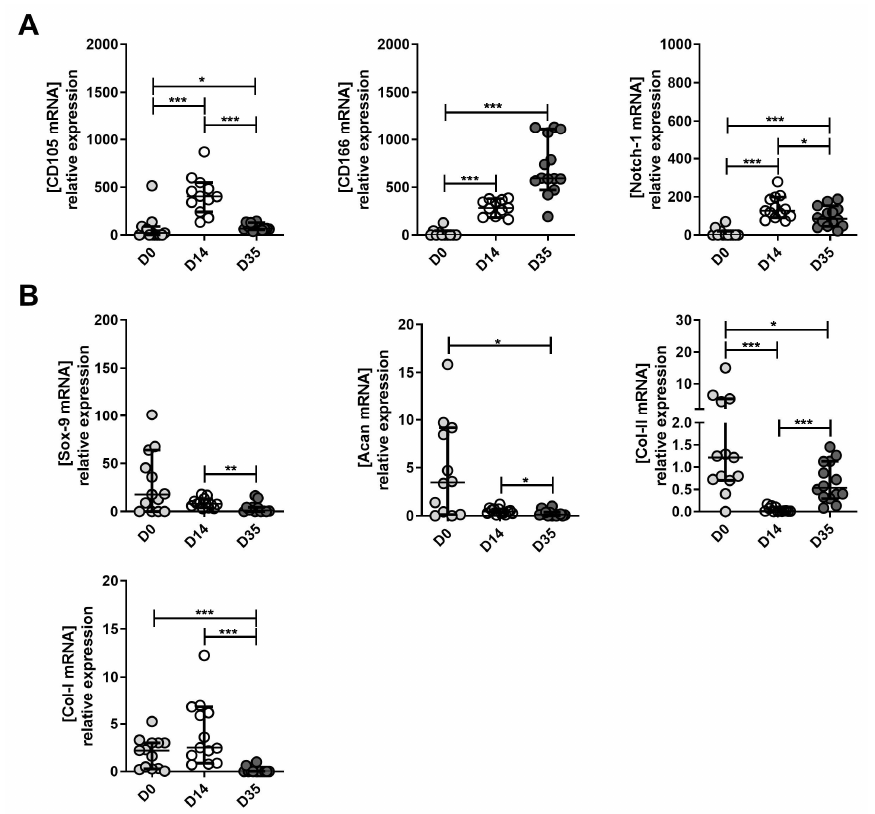
Figure 6. The expression of MPC, chondrocyte and hypertrophic chondrocyte markers between moderate OA-derived tissue (D0), expanded (D14) and re-differentiated cells (D35). ( A ) Changes in mRNA expression levels of CD105, CD166 and Notch 1 (MPC markers) in D0, D14 and D35. ( B ) The changes in mRNA expression levels of Sox9 (MPC marker), Acan and Col II (chondrocytes markers) and Col I (hypertrophic chondrocytes marker) between D0, D14 and D35. D0 is used as the control to normalize expression levels. * p < 0.05, ** p < 0.01, *** p < 0.001, non-parametric Kruskal–Wallis and Mann–Whitney test were used.